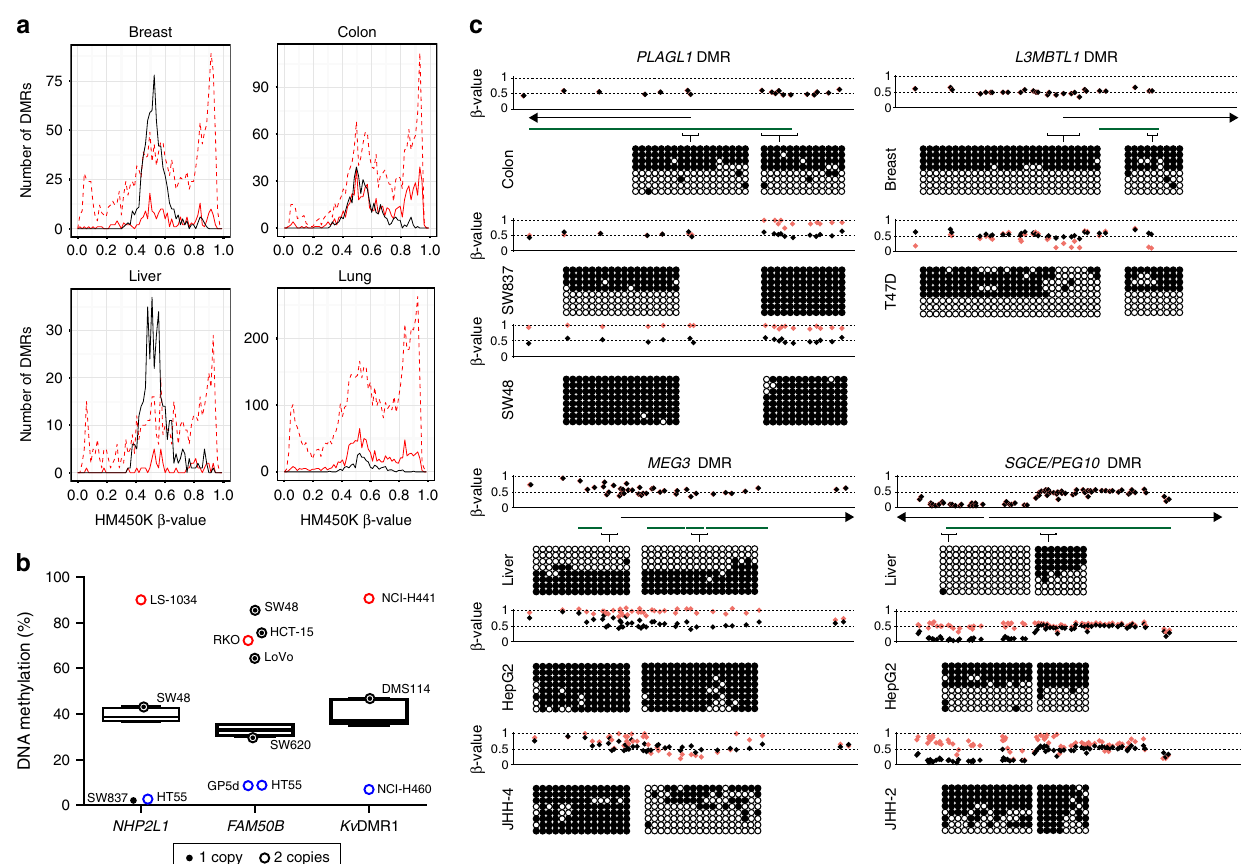
Fig. 2 Methylation anomalies at imprinted DMRs in cancer cell lines. a Line graphs of the number of cancer cell lines showing methylation defects in imprinted DMRs. Control DNA methylation frequencies are depicted by black solid line with a β -values near 0.5 indicative of one methylated and one unmethylated allele. Dashed line represents total methylation defects irrespective of the underlying CNA status, whereas solid red line represents the methylation pro fi les in samples carrying normal 2:1 copy number complement. b Pyrosequencing quanti fi cation for the NH2PL1 and FAM50B DMRs in colorectal cell lines with different CNA status. The average methylation of eight controls colon biopsies were used to generate Turkey box-and-whisker plots with whiskers spanning from 25th to 75th percentiles ± 1.5 interquartile range to highlight outliers. A similar analysis was performed for the Kv DMR1 in lung cancer cell lines. Number of copies is represented by circle size ( inner , minor allele; outer , total copy number). c Detailed methylation maps of four imprinted DMRs as determined by Illumina In fi um HM450k methylation beadChip arrays. Each dot represent the position of single probes with the pro fi les of cancer cell lines ( red data points) compared to the respective normal tissues ( black data points). The green bars highlight the position of the CpG islands associated with each DMR and the arrow the nearest transcripts. Two different bisulphite PCRs were performed per region to con fi rm the strand-speci fi c methylation pro fi le as determined by cloning and direct sequencing. Each circle represents a single CpG dinucleotide on a DNA strand (results for multiple DNA strands are depicted as rows ), fi lled circles indicate a methylated cytosine, and open circles an unmethylated